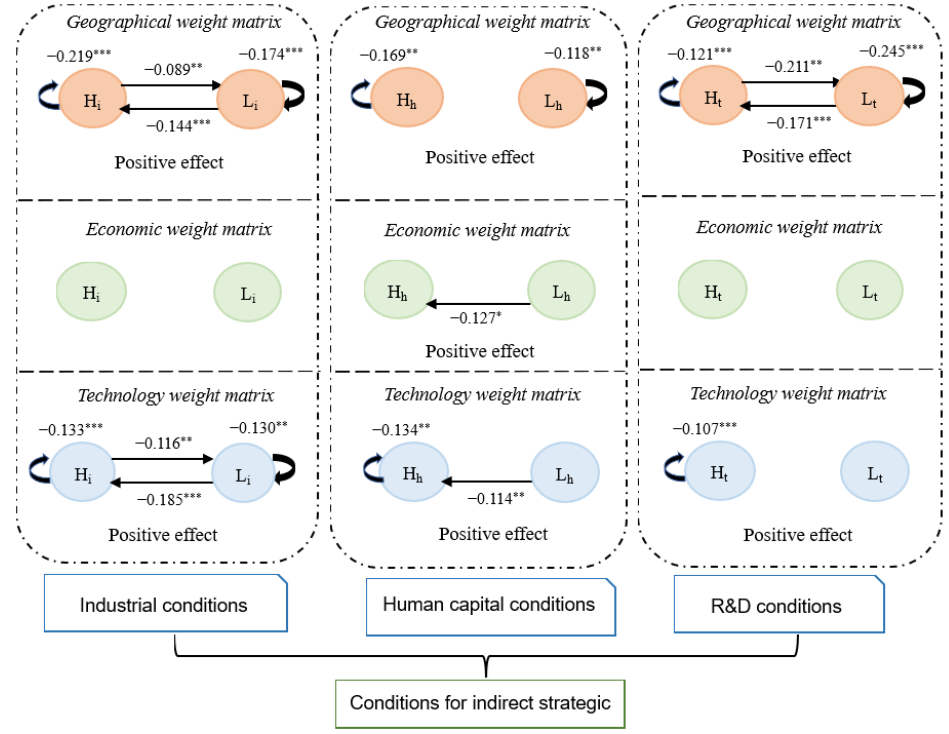
Figure 7. Conditions for indirect emission reduction interaction. Note: These coefficients are the estimated results of the spatial lag term ( θ ) of agricultural technological innovation in the partition SDM. ***, **, and * indicate significance at the 1%, 5%, and 10% levels, respectively. Hi : regions where the aggregation level of the agricultural industry is higher than the national average, Li : regions where the aggregation level of the agricultural industry is lower than the national average. H h : regions where the human resources level is higher than the national average, L h : regions where the human resources level is lower than the national average. Ht : regions where R&D is higher than the national average, Lt : regions where R&D is lower than the national